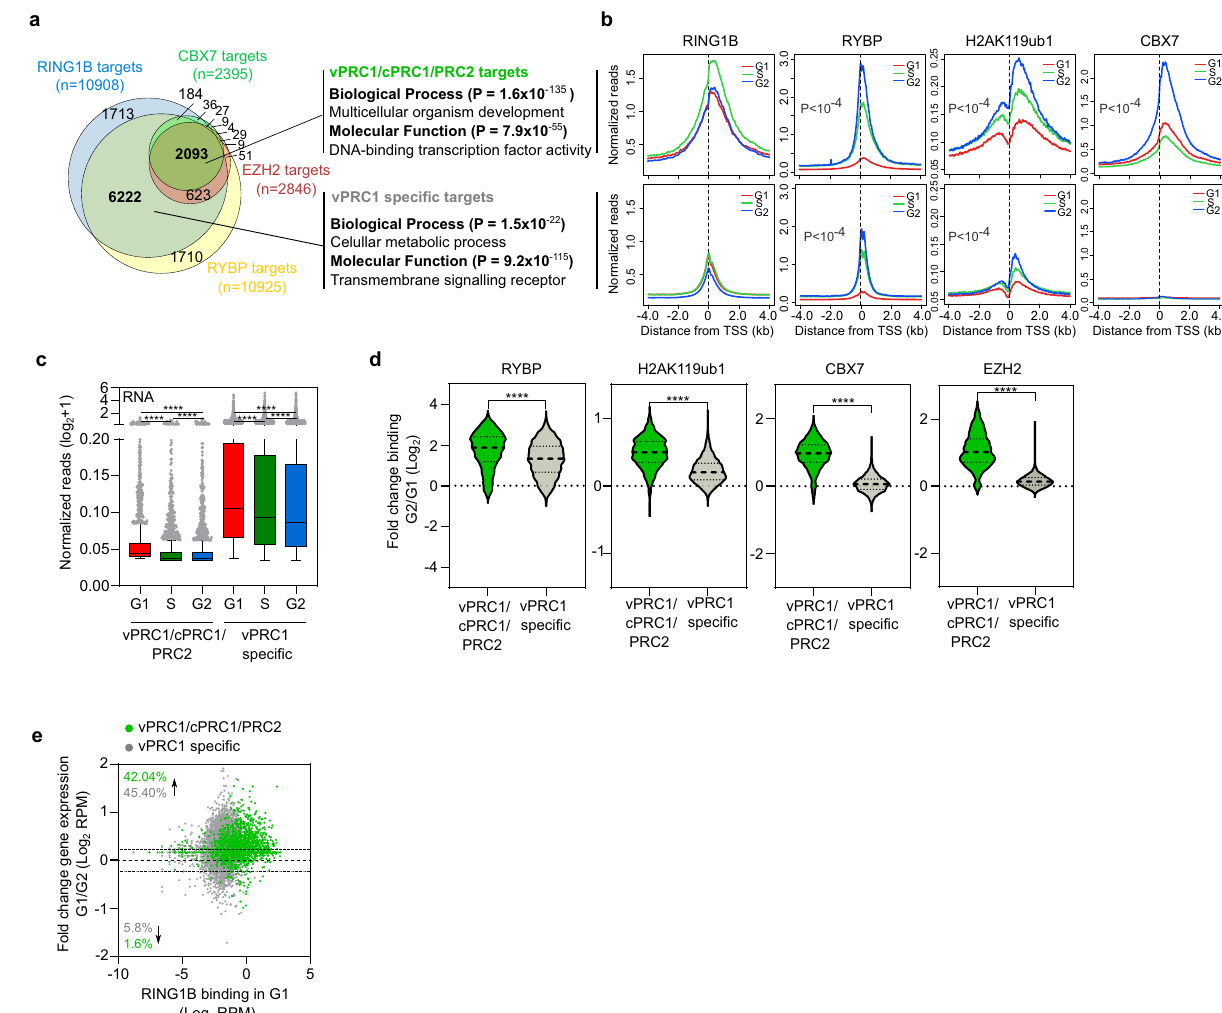
Fig.4|Developmentallyregulatedtranscriptionfactorsarecommontargetsof PRC2/cPRC1/vPRC1 that display enhanced recruitment of PRC1 during G2 compared totheG1 phase.a Venn diagram showing the overlapbetween RING1B (blue), RYBP (yellow), CBX7 (green) and EZH2 (red) target promoters. Gene Ontology analysesof genepromoters boundbyvPRC1,cPRC1 and PRC2(n=2093) or by vPRC1 only ( n =6222) are shown on the right. Fisher ’ s exact test was used to calculate the P values. b Average binding pro fi le around the TSS of RING1B, RYBP, H2AK119ub1 and CBX7 at vPRC1/cPRC1/PRC2 (top row) or vPRC1 speci fi c (bottom row) target genes (as de fi ned in a ) in G1 (red), S (green) and G2 (blue) phases. P indicatesone-wayANOVAtest p -value. c Boxplotscomparing4sU-seqnascentRNA reads (RPMs, TSS to +3Kb) of vPRC1/cPRC1/PRC2 targets ( n =2093) and vPRC1 speci fi c targets ( n =6222) at indicated phases of the cell cycle. Boxes show